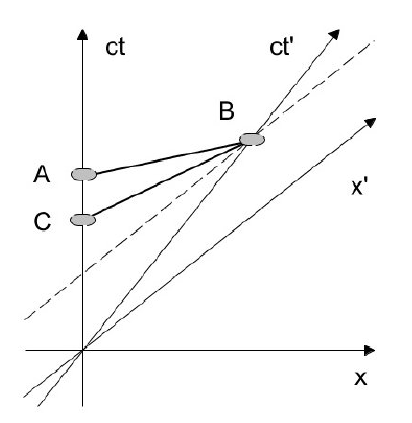
Figure 8. Antitelephone paradox (see text for